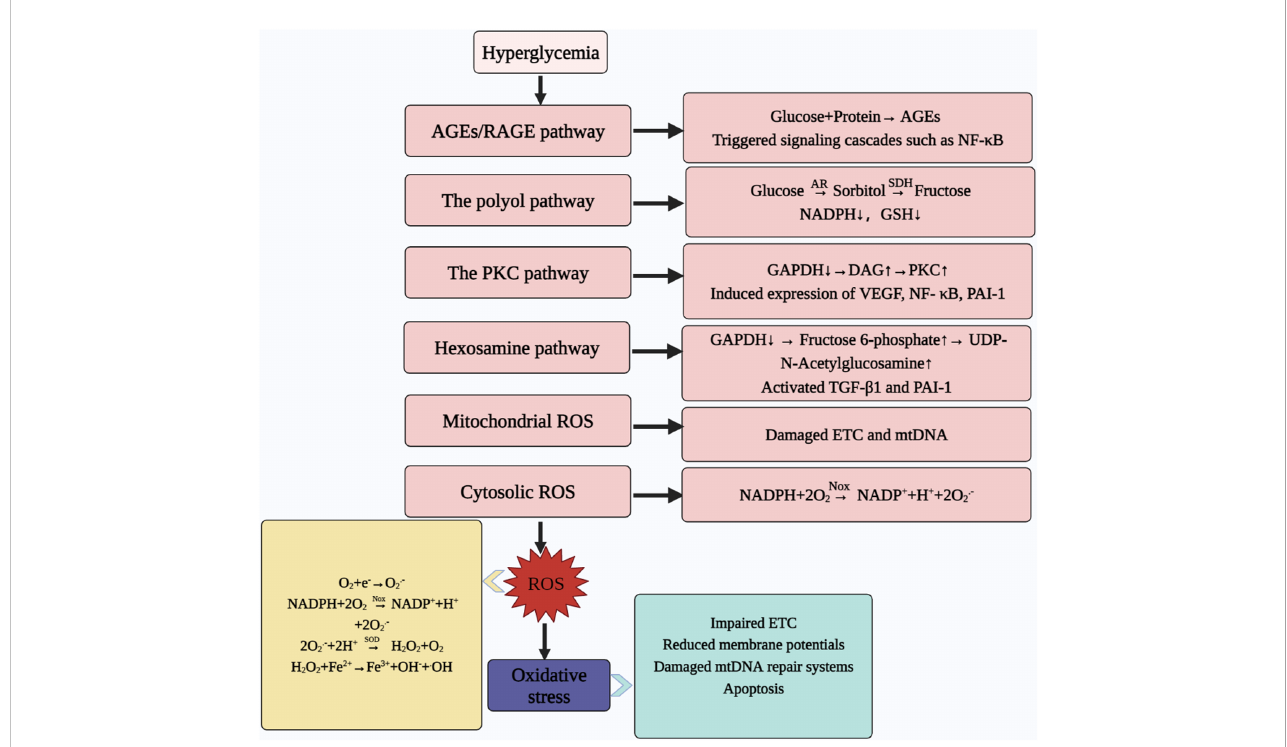
FIGURE 4 Abnormal metabolic pathways caused by hyperglycaemia. Hyperglycemia contributes to ROS production through the AGEs pathway, hexosamine pathway, PKC pathway, and polyol pathway; meanwhile, mitochondria and cytoplasm are also important sites for ROS production, which ultimately leads to oxidative stress. At the same time, oxidative stress can contribute to ETC abnormalities, reduce MMP, damage the mtDNA repair system and promote apoptosis. AGEs, advanced glycosylation end products; RAGE, the receptor for AGEs; NF- Κ B, nuclear factor kappa-light-chain-enhancer of activated B cells; AR, aldose reductase; SDH, sorbitol dehydrogenase; NADPH, nicotinamide adenine dinucleotide phosphate; GSH, reduced glutathione; GAPDH, glyceraldehyde-3-phosphate dehydrogenase; DAG, diacylglycerol; PKC, protein kinase C; VEGF, vascular endothelial growth factor; PAI-1, plasminogen activator inhibitor-1; TGF- Β 1, transforming growth factor; ROS, reactive oxygen species; ETC, electron transfer chain; mtDNA, mitochondrial DNA; NOX, NADPH oxidases; NADP + , nicotinamide adenine dinucleotide phosphate oxidized; O 2.- , superoxide anion; SOD, superoxide dismutase; H 2 O 2 , hydrogen peroxide; (cid:129) OH: hydroxyl